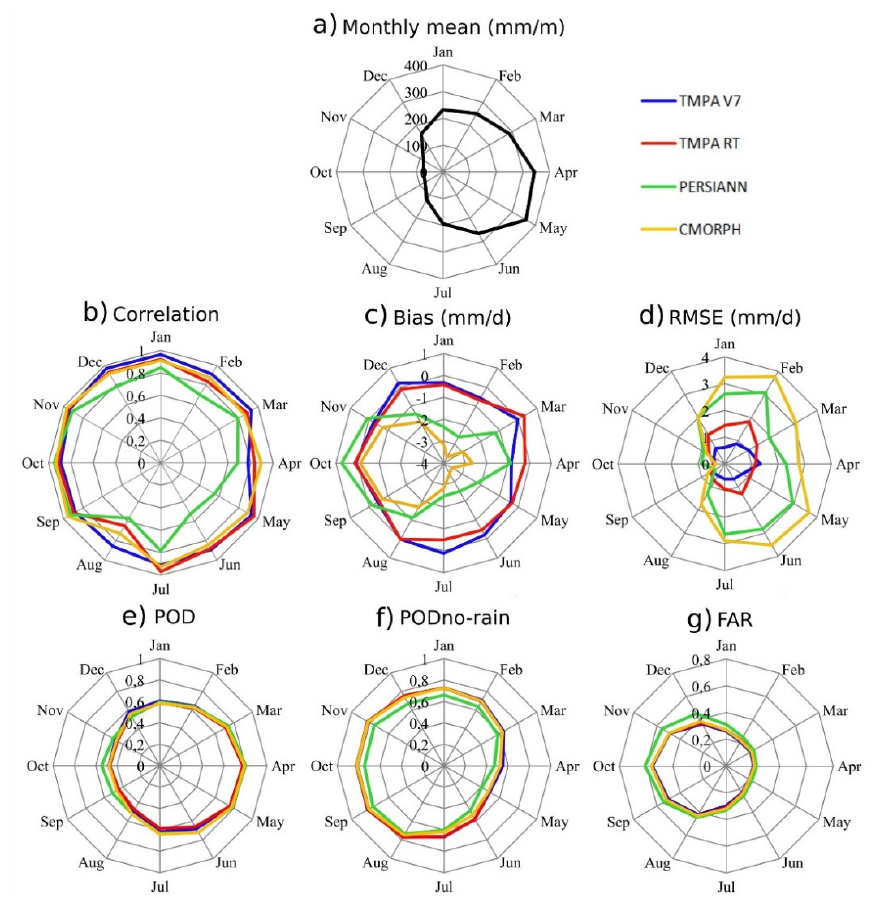
Figure 3. Monthly statistical comparison from the daily averages between the in situ rain gauges and satellite estimated products. ( a ) The average monthly accumulation (mm/month) for the entire study area. The others graphs depict the daily statistical errors: ( b ) correlation, ( c ) bias (mm/d), ( d ) RMSE (mm/d), ( e ) POD, ( f ) PODno-rain and ( g ) FAR. Months have been shortened, Jan = January, Feb = February, Mar = March, Apr = April, May, Jun = June, Jul = July, Aug = August, Sep = September,